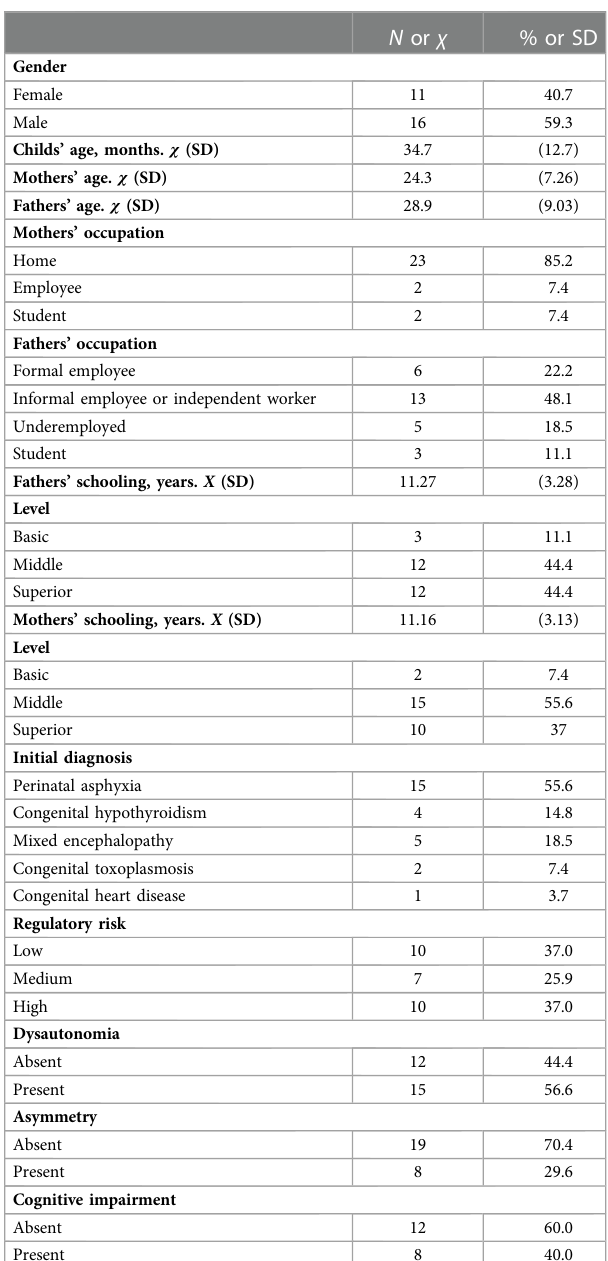
TABLE 1 Sociodemographic and clinical characteristics of the